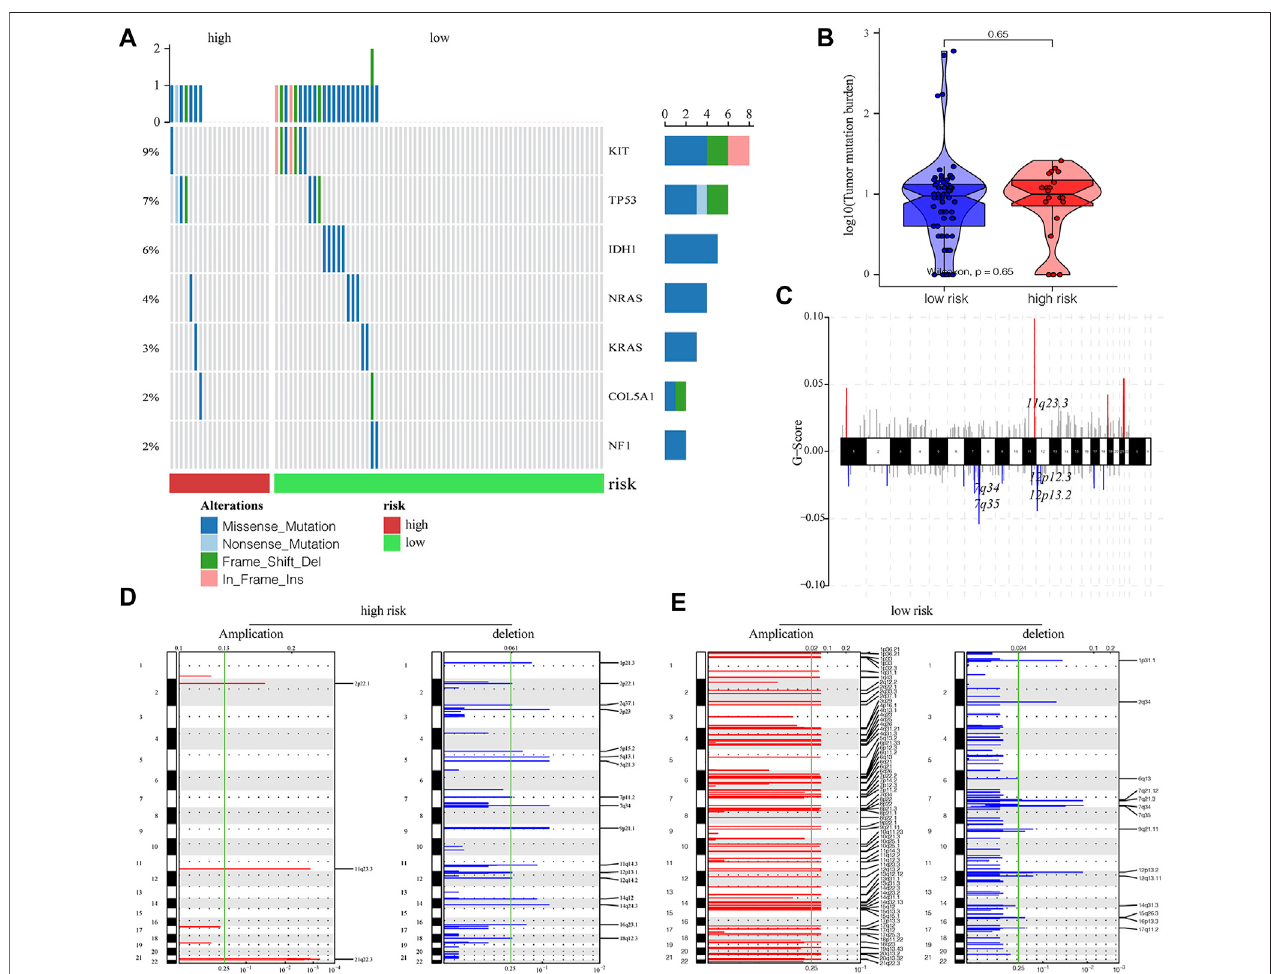
FIGURE 5 | In fl uence of different m6A-related lncRNAs risk groups on the genetic variation of AML patients. (A) Mutation maps of common cancer driver genes between high- and low-risk groups. The waterfall chart displays the mutation information of every gene in each sample, of which various colors indicated different mutation types. The subsection before the legend demonstrated mutational burden. (B) Compared with the low-risk group, the high-risk group obtained ahigher tumor mutation level, but the difference was not statistically signi fi cant ( p = 0.65). (C) Overall level of CNV in TCGA-LAML patients. (D,E) Changes in the copy number levels of different genes between the high- and low-risk groups, among which red color represents the genes with signi fi cantly increased copy number, and blue color represents genes with signi fi cantly missing copy